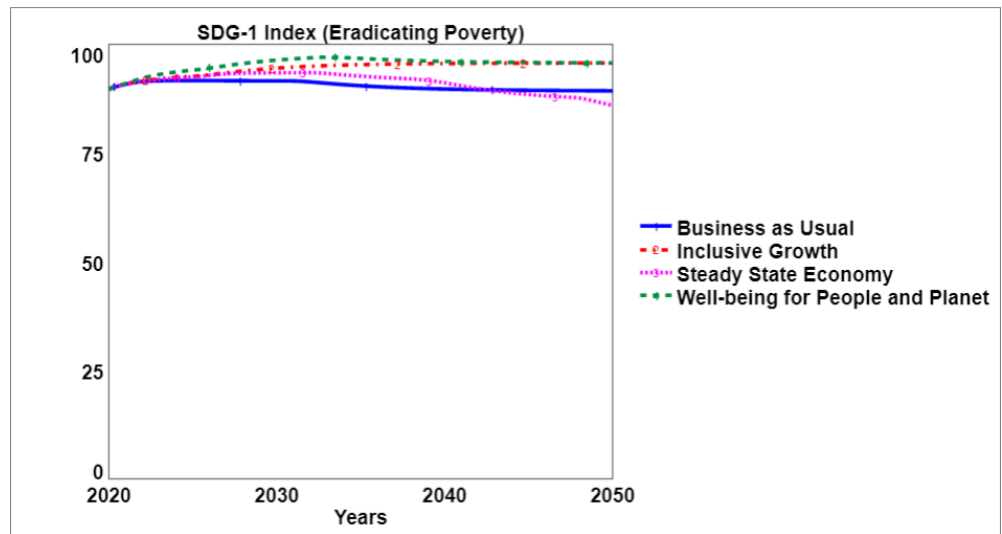
Figure 7. Implementation of SDG-1 in the four scenarios in Iran in the period 2020 to